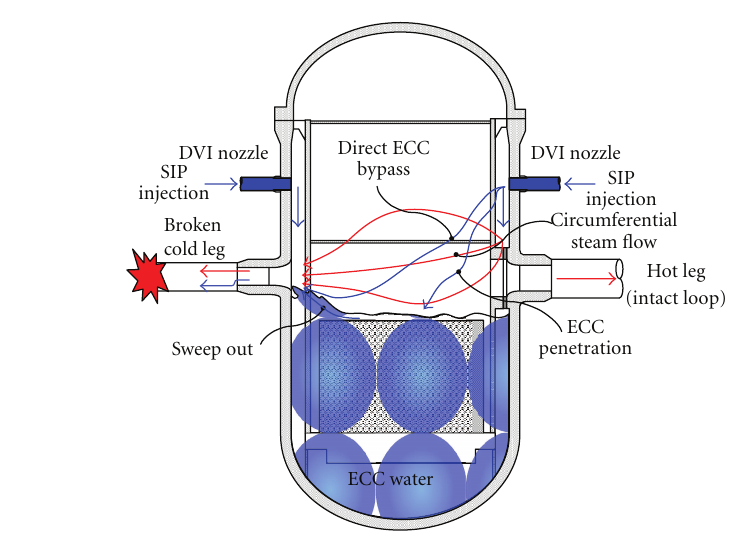
Figure 3: A schematic diagram of the direct ECC bypass and sweepout